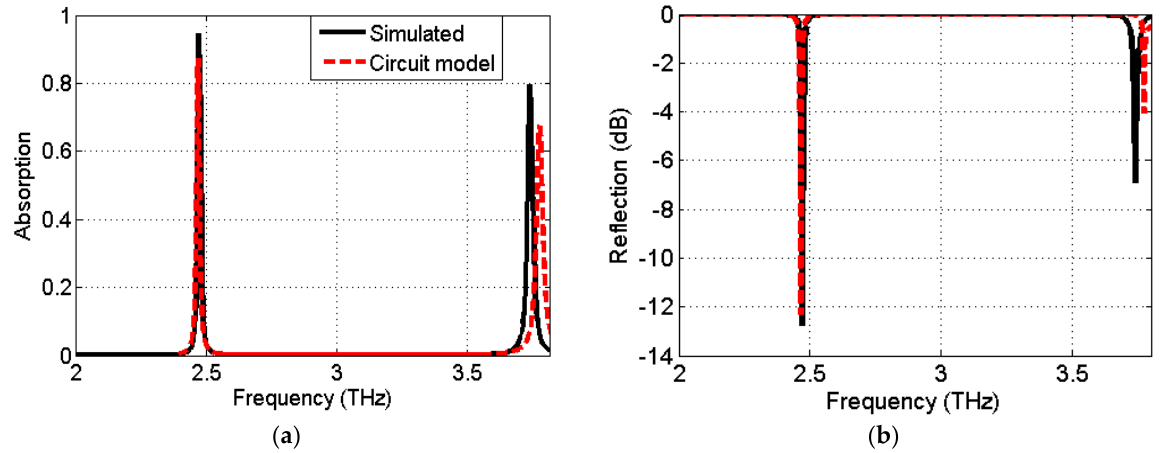
Figure 3 . ( a ) Absorption spectra ( b ) reflection coefficient of the proposed absorber, where the holes are drilled out of the PEC film. The parameters of the structure are: L = 40 µ m, w = 20 µ m, t s = 30 µ m and t m = 2 µ m.